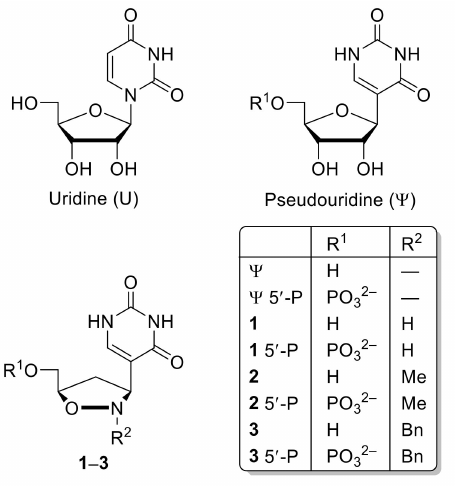
Figure 1. Chemical structures of U, Ψ and of its isoxazolidinyl nucleoside analogs 1 – 3